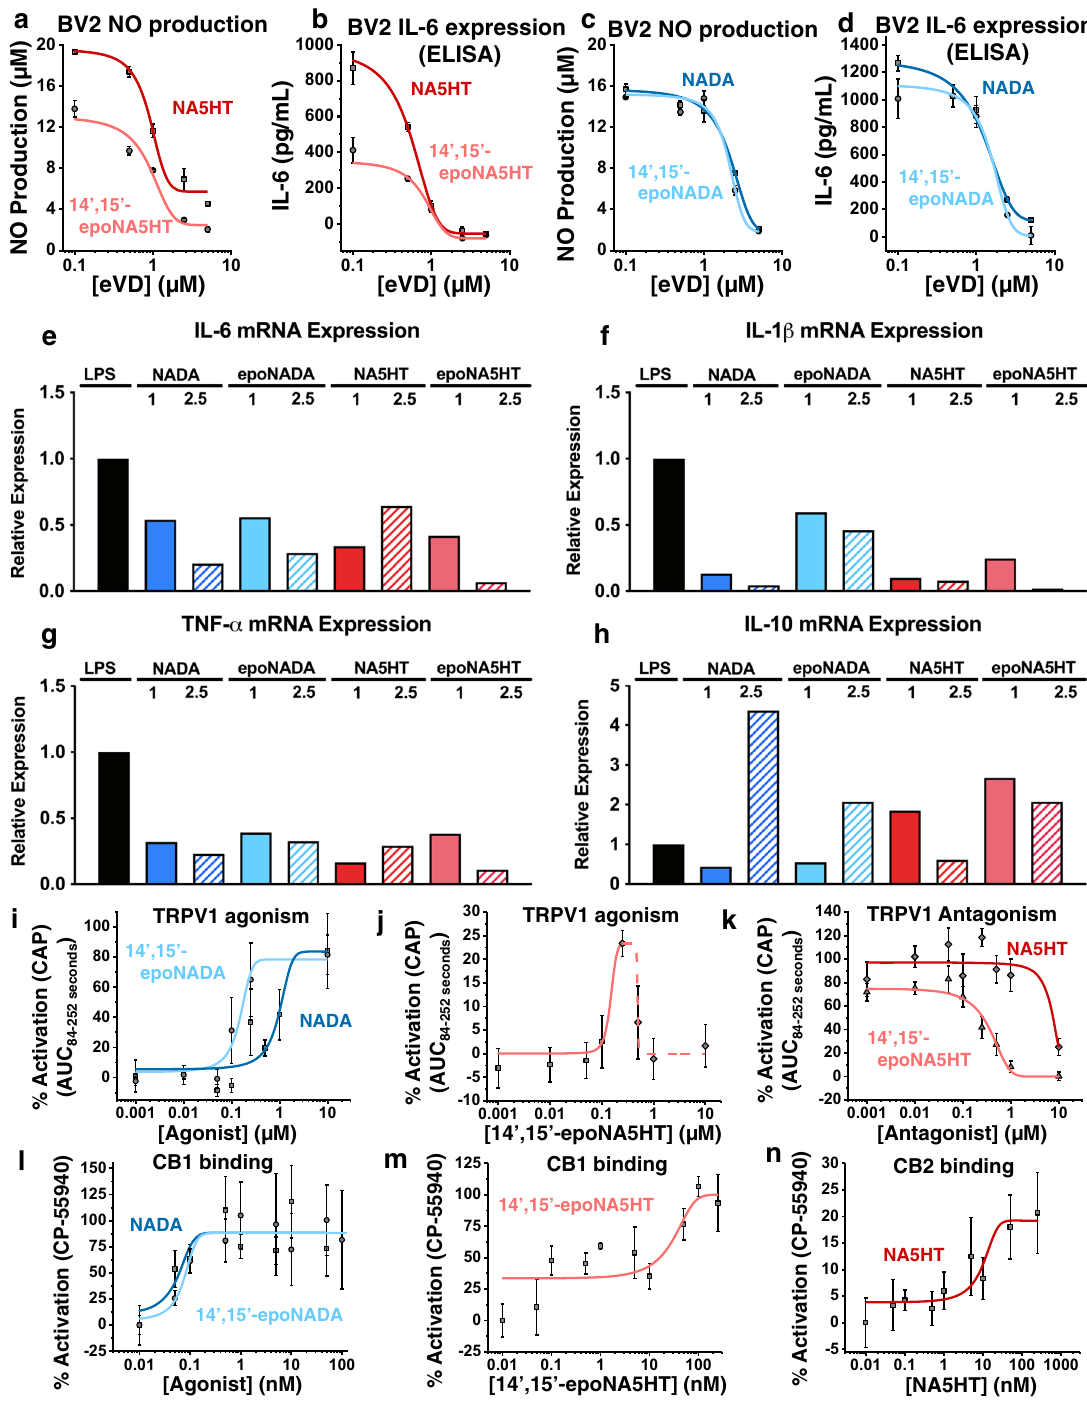
Fig. 5 Anti-in fl ammatory actions of eVDs and receptor activation. a – d Anti-in fl ammatory effects of eVDs and epoxy-eVDs were determined by preincubating eVDs and epoxy-eVDs with BV2 cells for 4 h prior to stimulation by 25 ng mL − 1 LPS. Data represents the mean ± SEM of n = 3 independent experiments. a Dose-dependent inhibition of nitric oxide (NO) production by NA5HT and 14,15-epoNA5HT as determined by Griess Assay. b Dose- dependent reduction of IL-6 protein expression (ELISA) by NA5HT and 14,15-epoNA5HT. c Dose-dependent inhibition of NO production and ( d ) IL-6 protein expression by NADA and 14,15-epoNADA. e – h Anti-in fl ammation experiments were repeated to measure pro-in fl ammatory Il-6 , Il-1 β , and Tnf- α and anti-in fl ammatory Il-10 mRNA expression in the presence of LPS. Data represents the average of three technical replicates. Data is reported as the mean relative expression. i – k eVD activation to TRPV1-transfected HEK cells was determined using a Fura 2-AM Ca 2 + -in fl ux assay. The B max of capsaicin (CAP) activation is de fi ned as 100%. Data represents the mean ± SEM of n = 6 (two sets of triplicate experiments on separate days). k Antagonism was determined by preincubating cells with antagonist prior to stimulating with 250 nM CAP. l – n eVD activation of CB1 and CB2 was determined by the PRESTO-Tango assay. B max of CP-55940 is de fi ned as 100%. Data represents the mean ± SEM of n = 6 (two sets of triplicate experiments on separate days). All data can be found in the Source Data fi